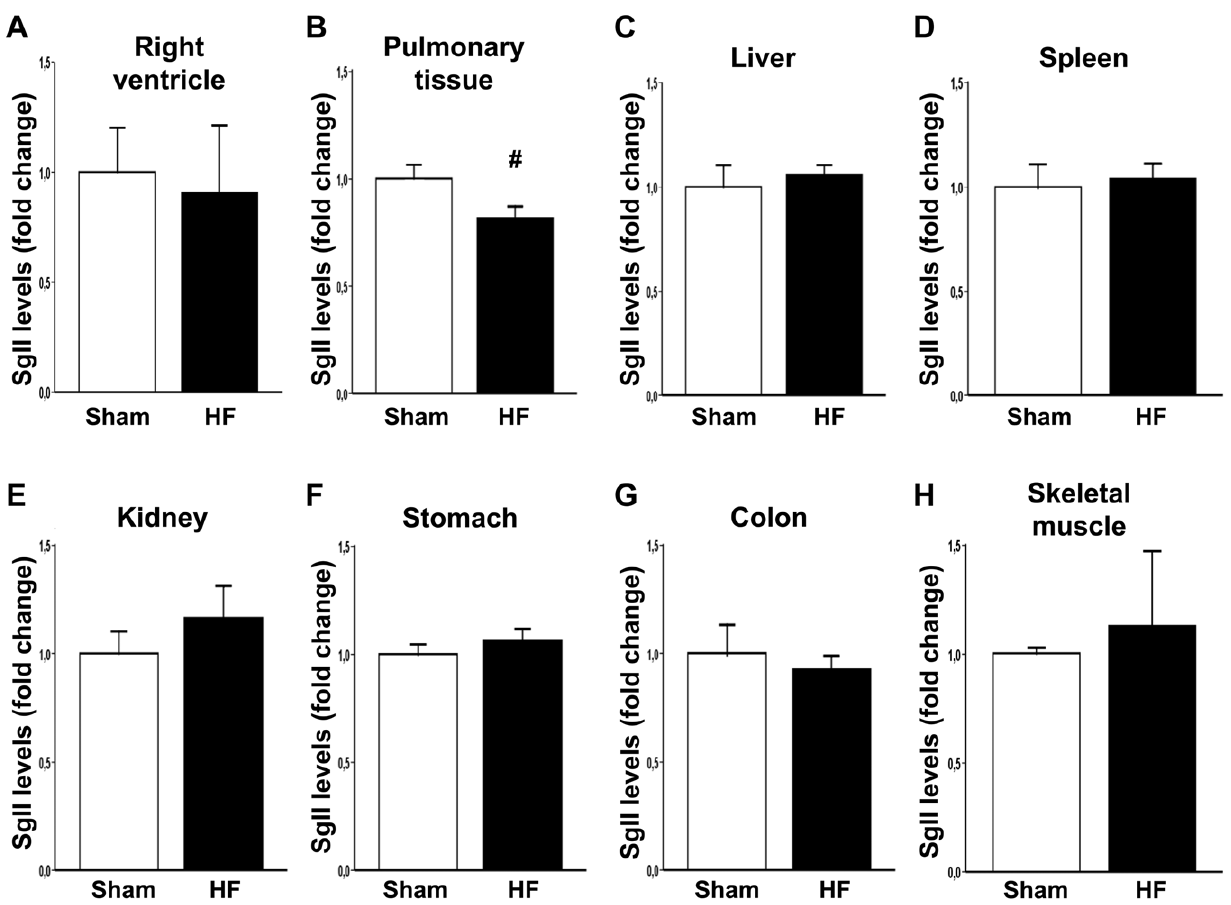
Figure 4. SgII production outside of the left ventricle in heart failure. SgII levels were decreased in pulmonary tissue during HF development, while levels were unchanged in the other tissues examined. SgII levels in the (A) right ventricle, (B) pulmonary tissue, (C) liver, (D) spleen, (E) kidney, (F) stomach, (G) colon, and (H) skeletal muscle were measured by RIA and are presented as fold change 6 SEM (n=6 for both groups, except pulmonary tissue: HF: n=14, sham: n=13). # p , 0.05.